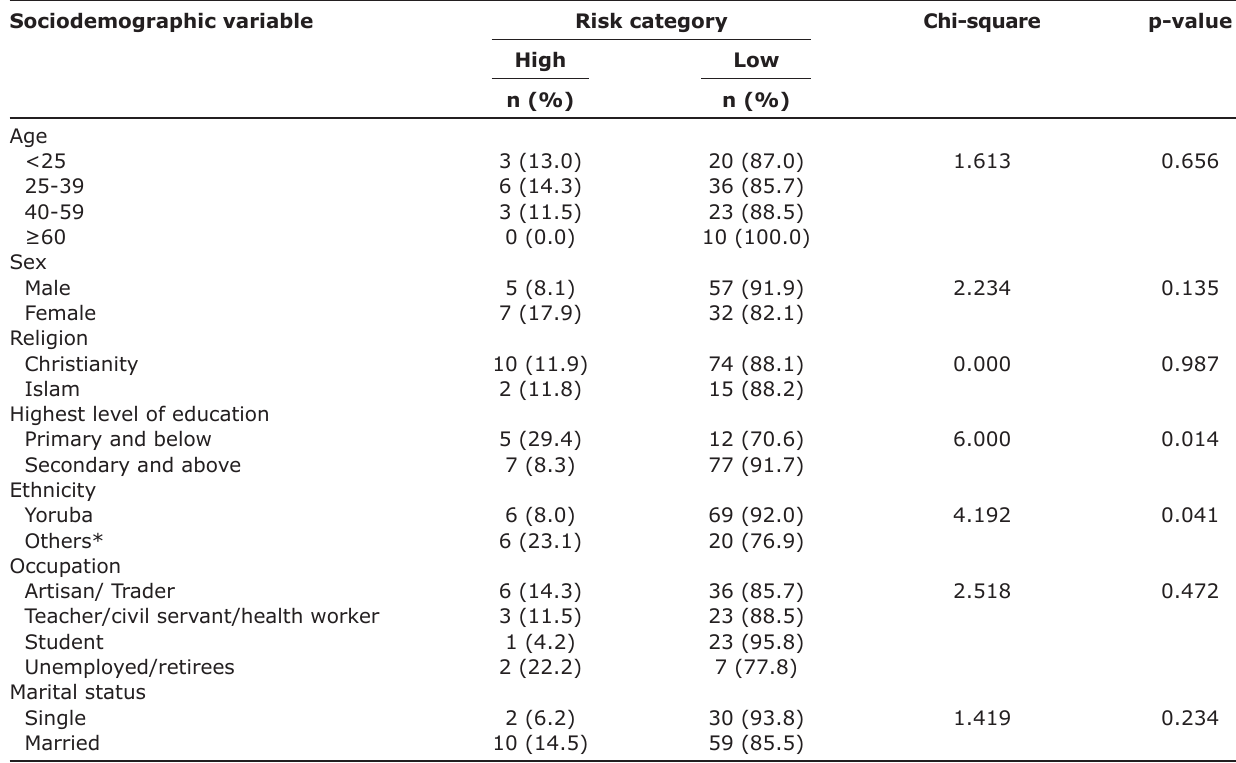
Table-3: Association between sociodemographic variables and risk category for Lassa fever among respondents. Sociodemographic